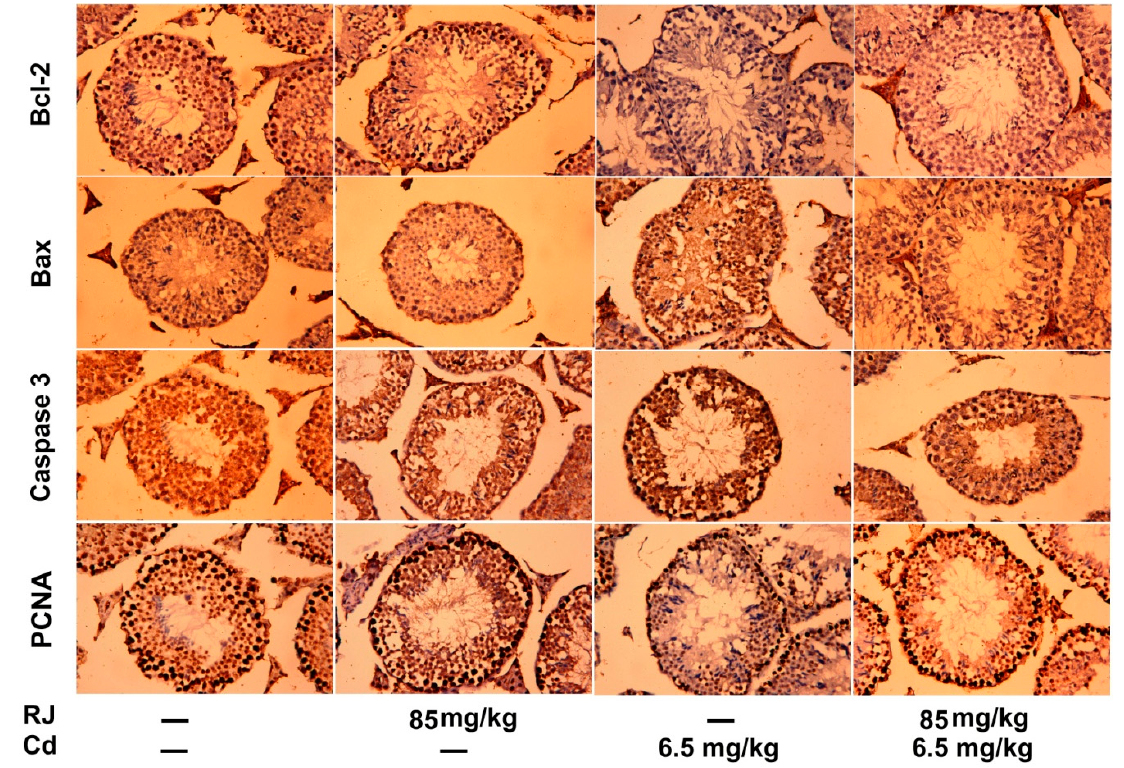
Figure 9. Photomicrographs showing changes in Bcl-2, Bax, caspase-3, and PCNA expression in the testicular tissue of mice following treatment with royal jelly (RJ) and cadmium chloride (CdCl 2 ). (magnification, 400×).